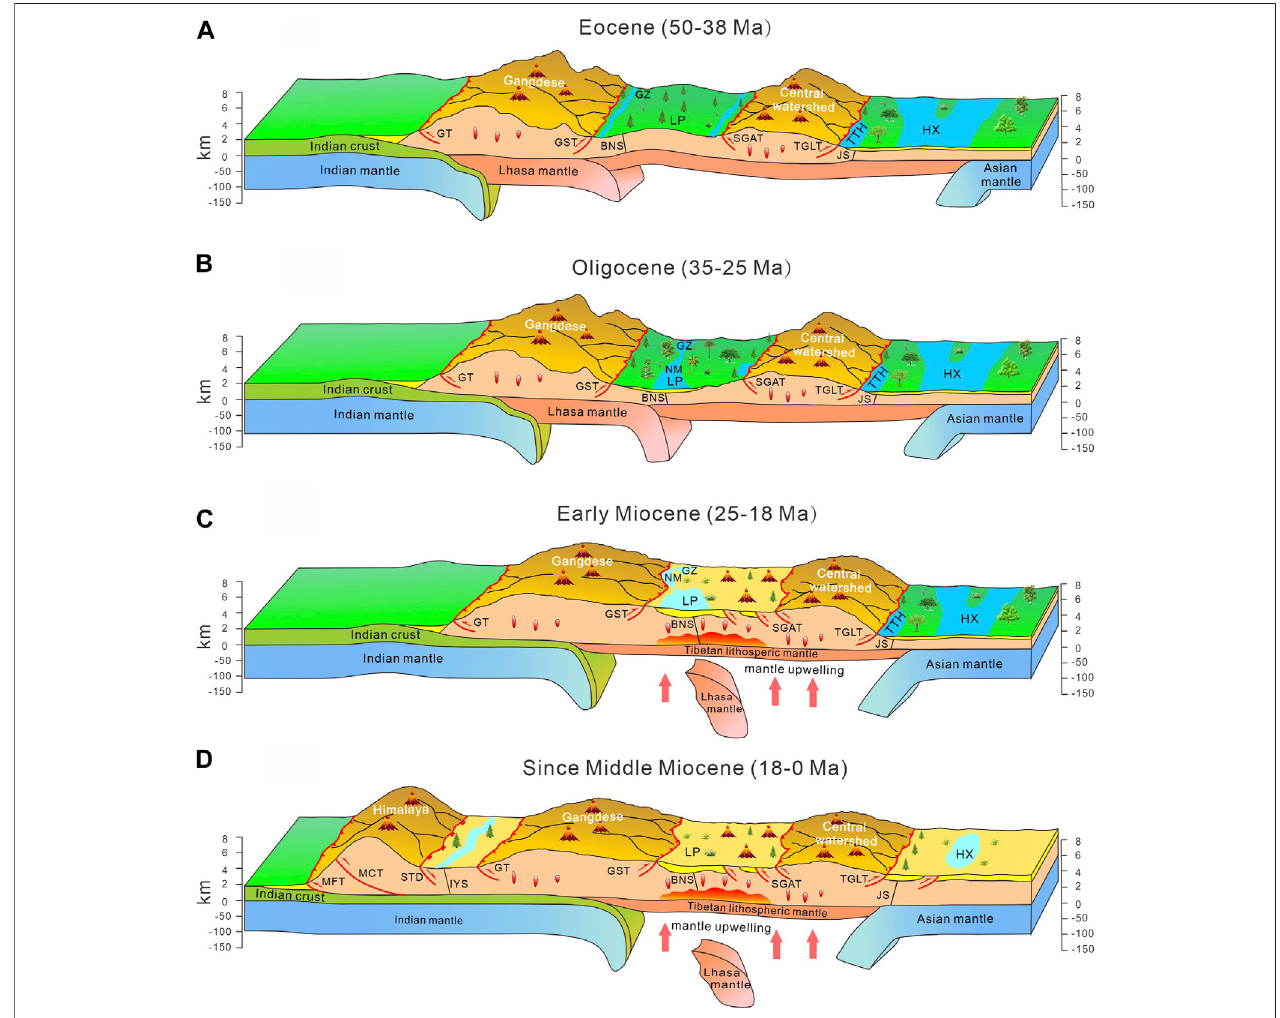
FIGURE 14 | Schematic surface uplift of the Tibetan Plateau, which can be subdivided into four stages: (A) two highlands, the Gangdese and central watershed mountains,wereseparatedbythreelowlands (B) thecentralTibetanlowlandalongBNSexperiencedanelevationdropof~2,000 mduringtheOligocene (C) thecentral Tibetan lowland suffered an rapid uplift and merged into the Tibetan Plateau during the Early Miocene (D) the south and north lowlands were elevated and merged into the Tibetan Plateau since the Middle Miocene, forming a fl at-surfaced topography similar to the modern Tibetan Plateau. GT, Gangdese Thrust; GST, Gaize-Siling Tso Thrust;SGAT,Shiquanhe-Gaize-Amdo Thrust;TGLT, Tanggula Thrust;MFT, MainFrontalThrust;MCT,Main Central Thrust;and STD, South Tibetan Detachment.